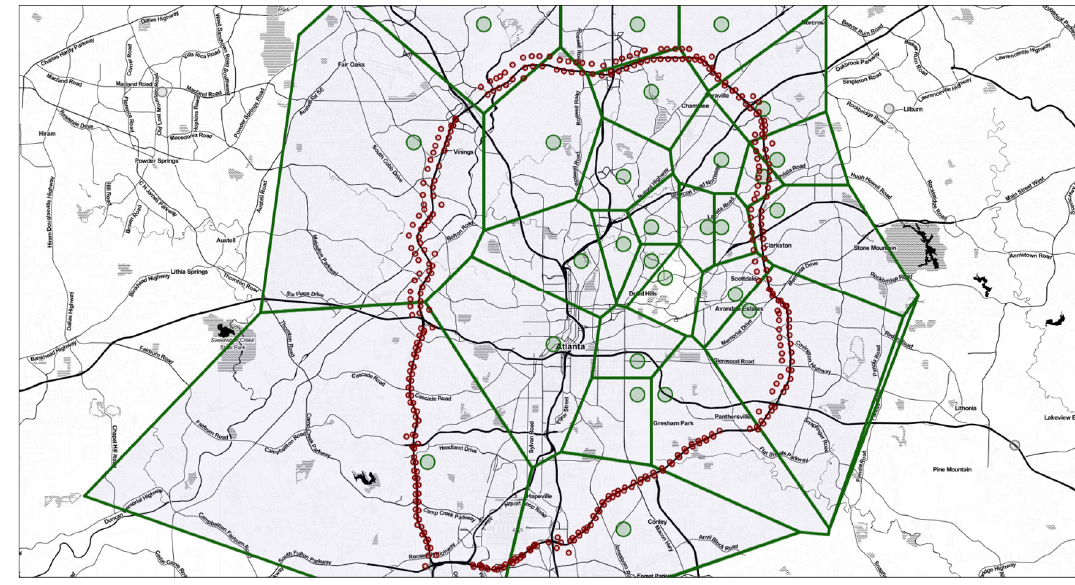
Figure 2. Voronoi diagrams of weather stations.